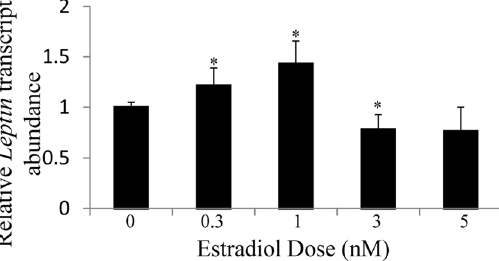
Figure 4. Lep transcript abundance increased at estradiol doses of 0.3 and 1 nM. 3T3-L1 adipocytes were treated for 24 hrs with estradiol doses ranging from 0.3–5 nM. Leptin transcripts were measured by qRT-PCR and normalized to an 18S rRNA control. The transcript abundance relative to untreated controls is reported as mean ± S.E.M of n ≥ 7 biological replicates; * Denotes p-value ≤ 0.05 when compared to the control with 2-sample, independent Student’s